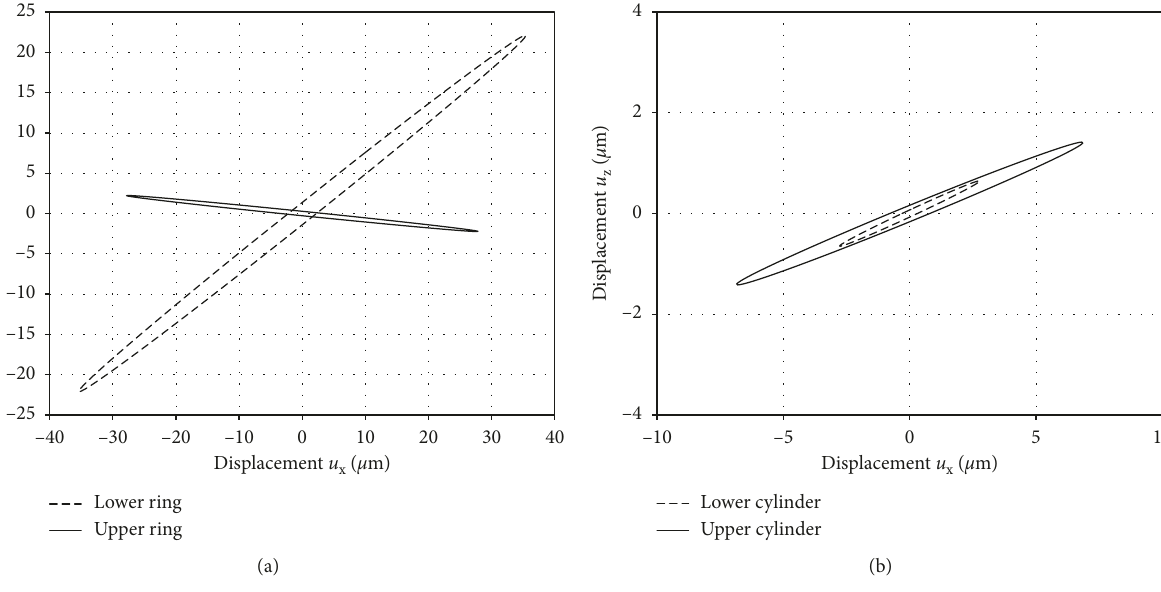
Figure 6: Contact point vibration trajectories of the ring-type actuator (a) and cylinder-type actuator